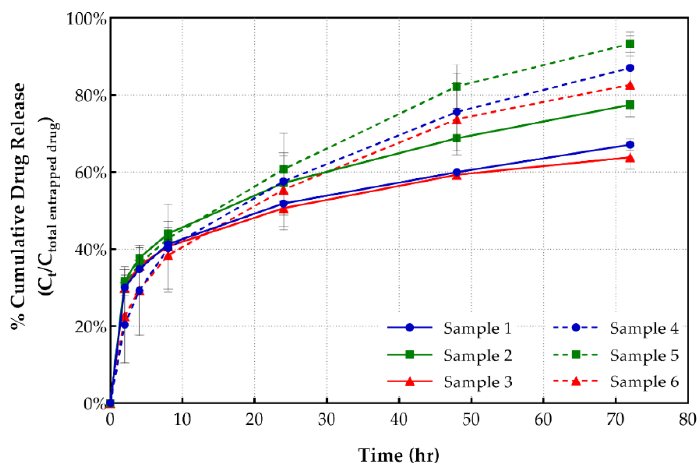
Figure 3. Cumulative release from PEGylated and conventional liposomes vs time. Table 3. Release data of shikonin-loaded